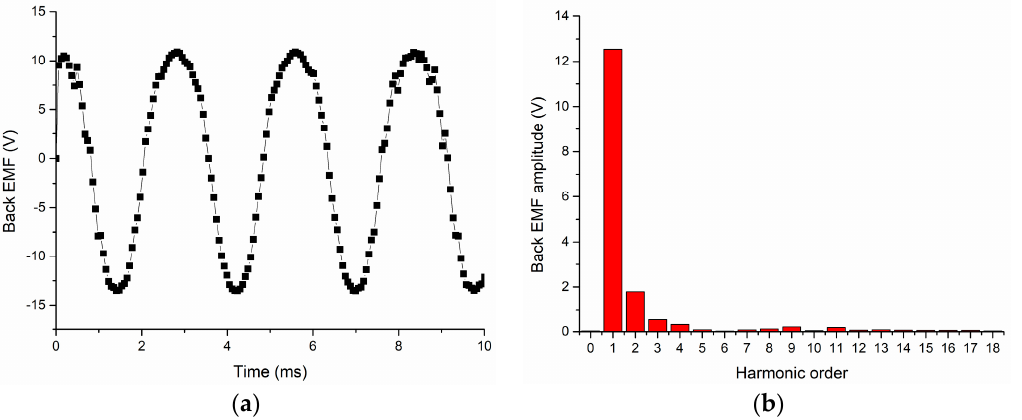
Figure 5. Back EMF of FRCPM at speed of 1800 rpm: ( a ) Back EMF per winding; ( b ) Harmonic contents and amplitude of back EMF.